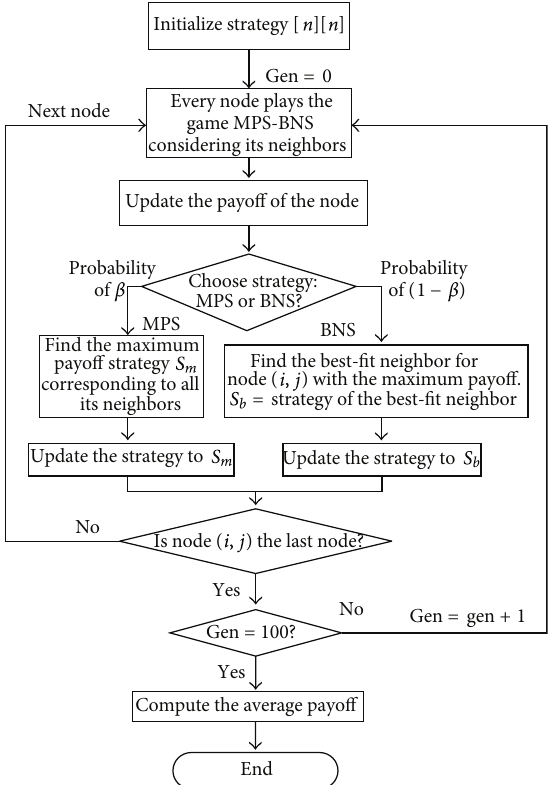
S 2: e game of MPS-BNS as pure strategy.